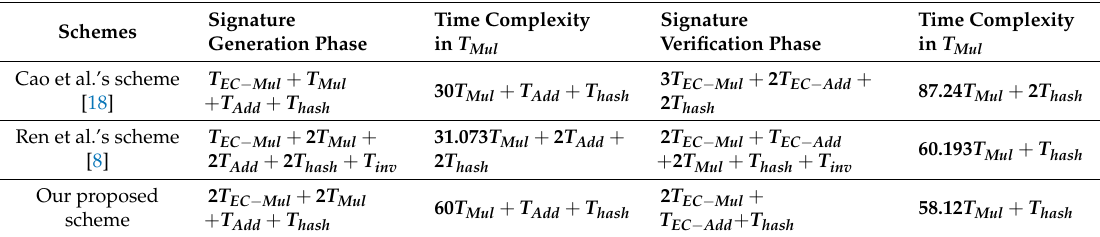
Table 3. The Time Complexity of Schemes in Unit of T Mul